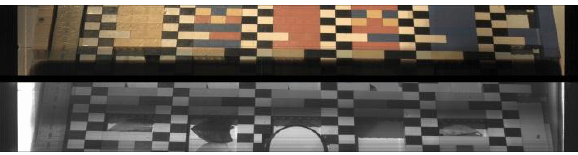
Figure 8 image acquired with the geospectral camera. Top: colour image acquired with the RGB sensor, Bottom: spectral image acquired with the panchromatic sensor with the linear variable